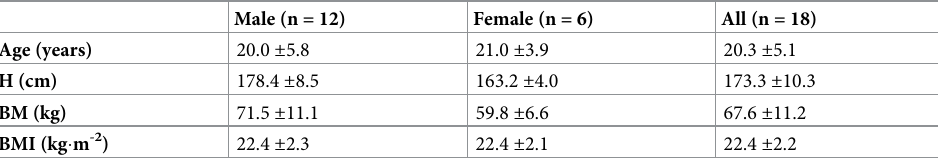
Table 1. Fencers characteristics: Age, body height (H), body mass (BM) and body mass index (BMI).